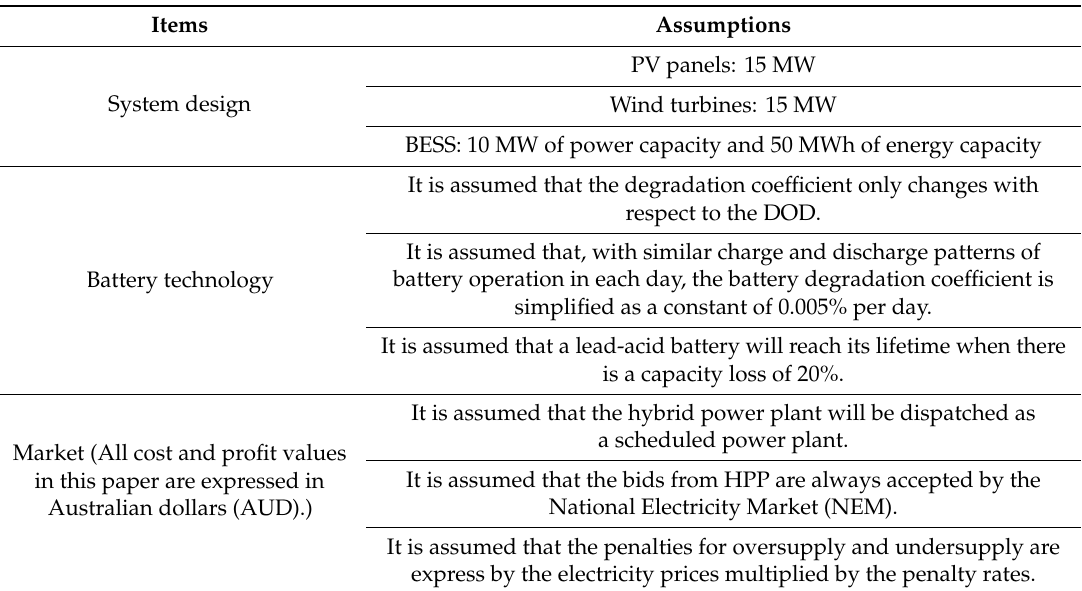
Table 3. Assumptions for the simulation